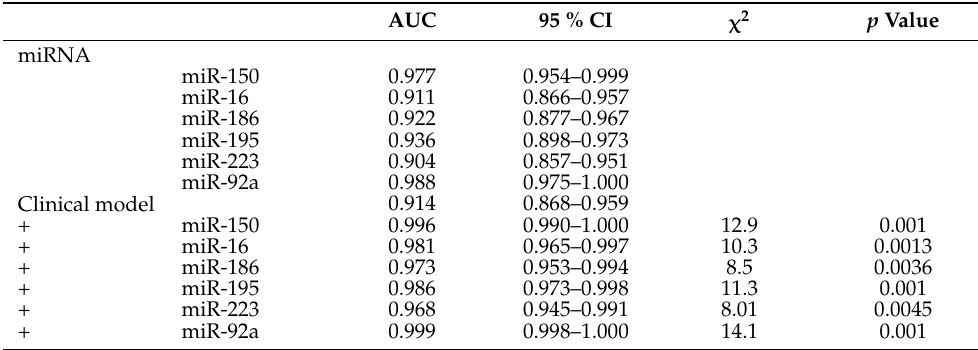
Table 3. Receiver operating characteristic (ROC) curve analysis testing the contribution of each selected circulating miRNAs to the basic clinical